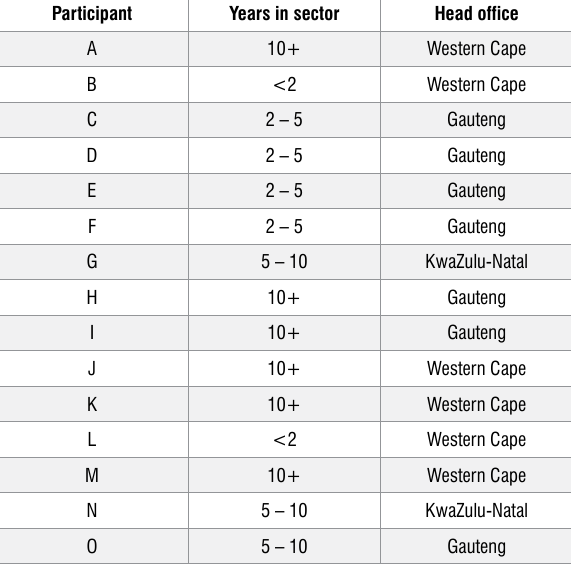
Interview participants, their years in the sector and head offices at the time of the interview